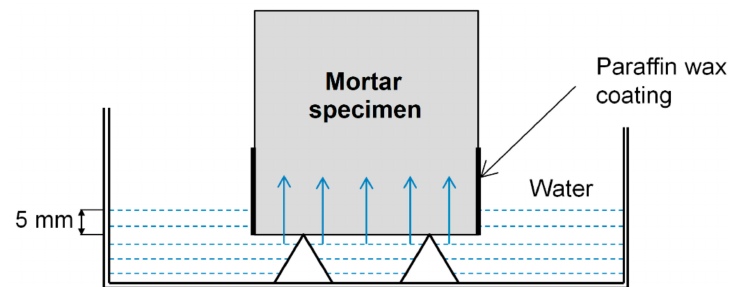
Figure 4. Schematic set-up for measuring the rate of water absorption in cement mortar specimens. Reproduced from [46].